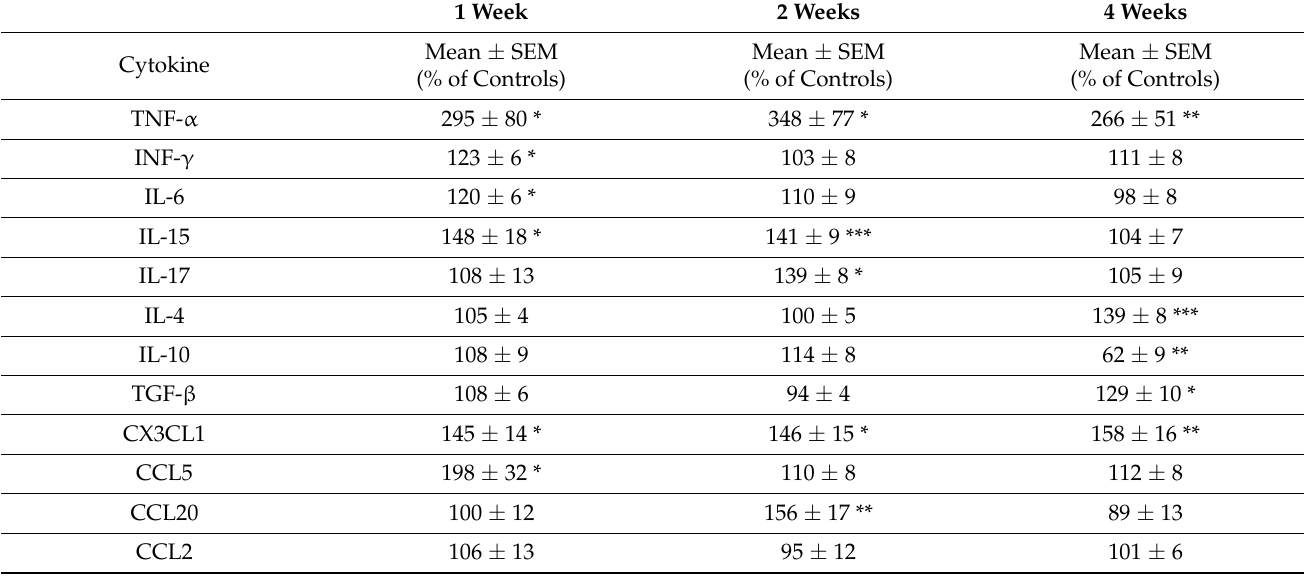
Table 3. Changes in plasma cytokine levels at different times of liver damage.